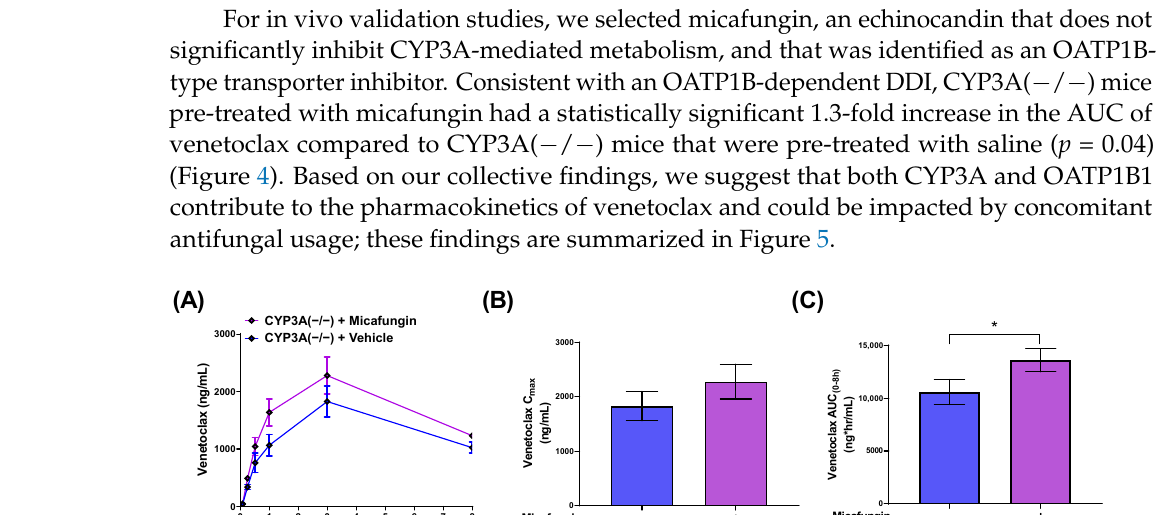
Figure 5. Summary figure. Both CYP3A and OATP1B1 contribute to the pharmacokinetics of ve- netoclax and are inhibited by antifungal drugs. Solid lines represent knowledge gaps clarified by our experiments. 4. Discussion The current study adds to a growing body of literature suggesting that antifungal drugs have a propensity to cause DDIs through CYP3A-independent mechanisms, high- lighting a previously unrecognized type of DDI of relevance to the antileukemic drug, venetoclax. In particular, we found that pretreatment with certain antifungals, such as ketoconazole, is associated with statistically significant increases in the systemic exposure to venetoclax in both wild-type mice and CYP3A( − / − ) mice, suggesting the existence of an additional mechanism that contributes to the observed DDI. Employing an array of in vitro and in vivo transport models, this mechanism was identified as OATP1B-mediated transport, a conclusion that is consistent with the notion that several prototypical CYP3A inhibitors, including ketoconazole, are well-established inhibitors of this class of trans- porters [7]. Our data also unambiguously validated the thesis that the elimination pathway of venetoclax is dependent, at least in part, on CYP3A-mediated metabolism, a conclusion that is consistent with a previously reported clinical DDI study of venetoclax given in